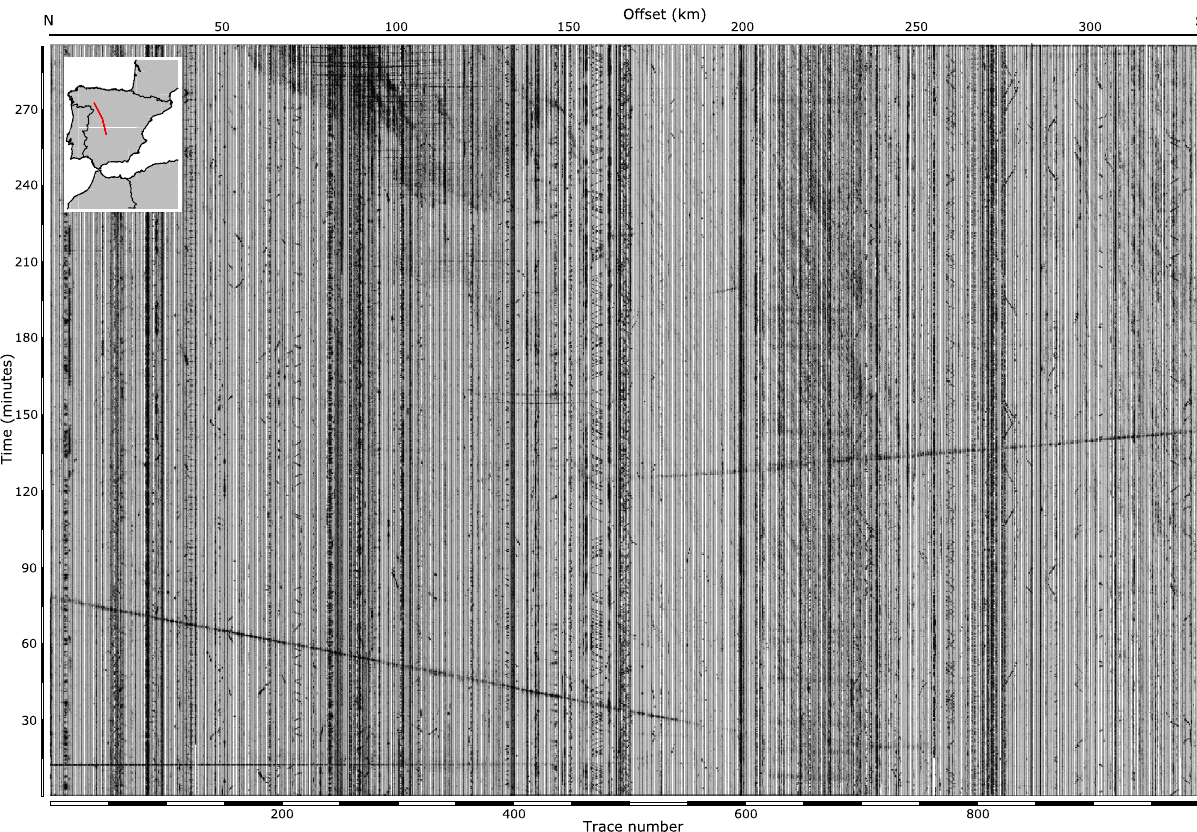
Figure 2. Raw seismic data acquired on July 3rd, 2019 along the CIMDEF profile. The time scale covers an interval of 5 h. Traces are displayed using a common amplitude scale. The lower horizontal scale refers to trace numbers. The distance to the northern end of the profile is shown by the upper horizontal scale. The inset map shows the geographic location of the profile. The S1 shot signal (Fig. 1) appears here as a subhorizontal line arriving approximately at 12